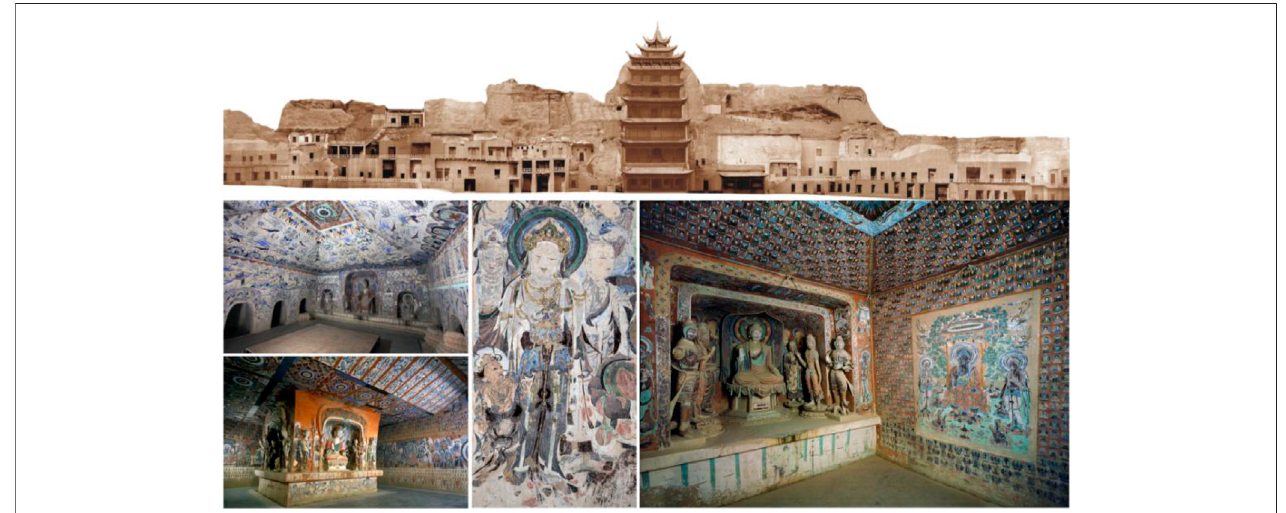
FIGURE 1 | Photograph of Mogao Grottoes and typical ancient murals in these